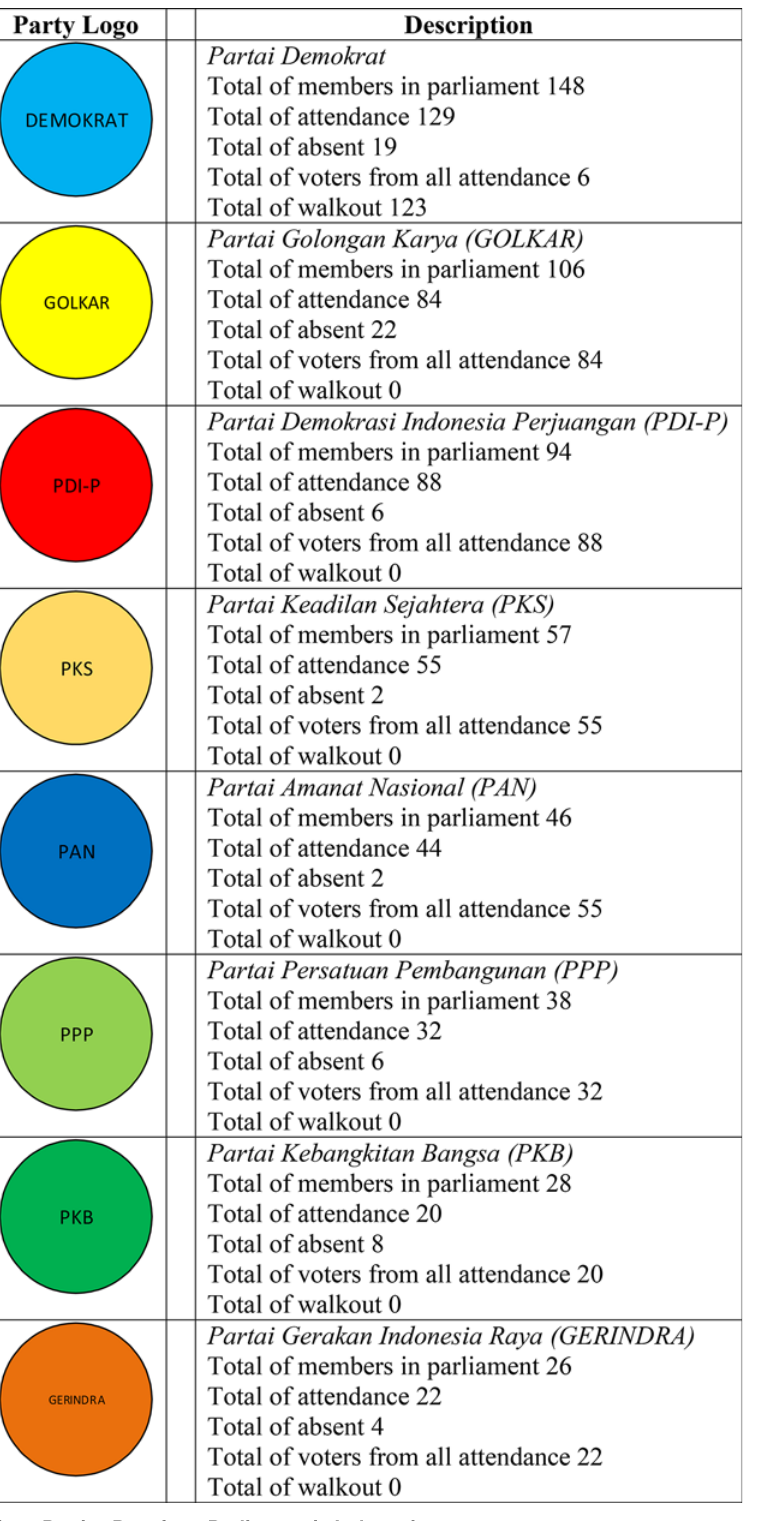
Fig 7. Parties Data from Parliament in